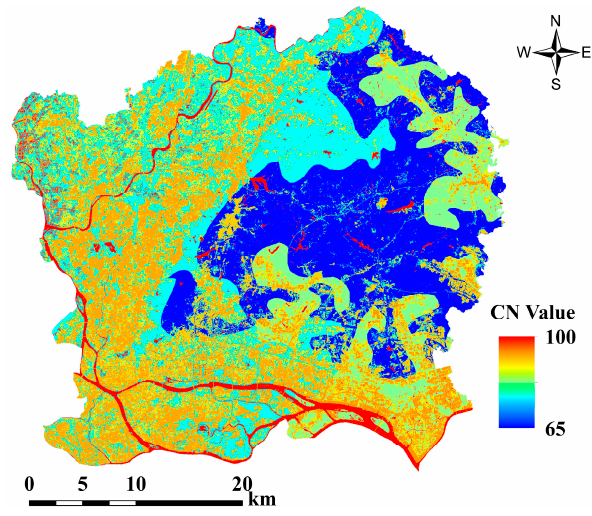
Figure 10. CN map of the impervious surface in this study.